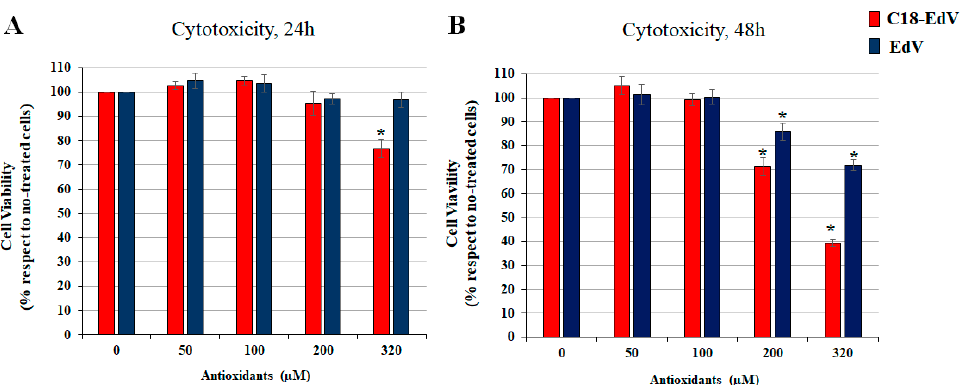
Figure 4. Cytotoxicity of C18-EdV in ARPE19 cells. The cells were treated with increasing concentrations of EdV, C18-edaravone for 24 h ( A ) and 48 h ( B ) in complete culture medium. The viability of treated-cells is reported as percentage respect with no-treated cells, which are considered as 100% of cell viability. The values in the figures are expressed as the means ± SD. Differences between control vs. C18-EdV or EdV were assessed using Tukey’s post hoc test, * p < 0.0001.